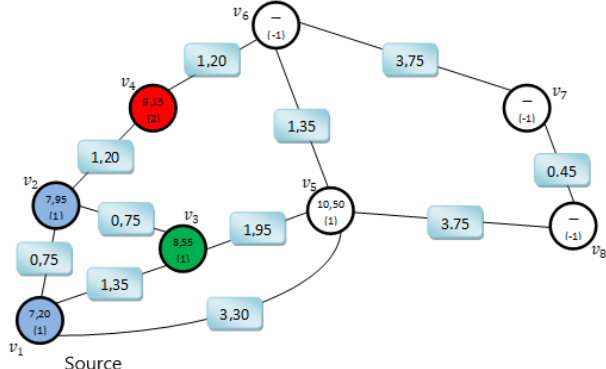
Figure 6. Finding the optimal path from peak 1—step 3.